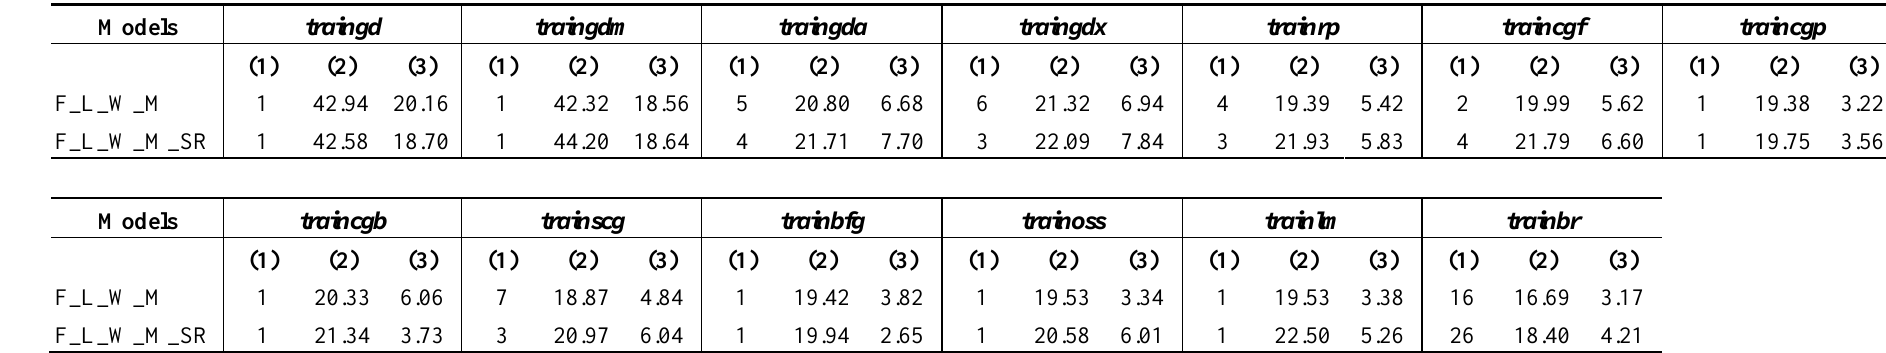
Table 2. Comparison of the minimum MAPE (5) for all the forecast models proposed (Experiment with Data Set B) and for all learning functions. Where: (1) optimal number of neurons for the specific model and learning functions; (2) MAPE (%) for the optimal number of neurons; and (3) standard deviation (%) for the optimal number of